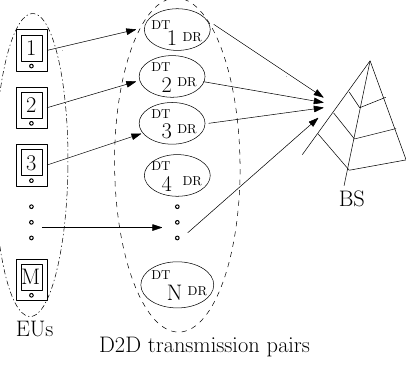
Figure 1. The system